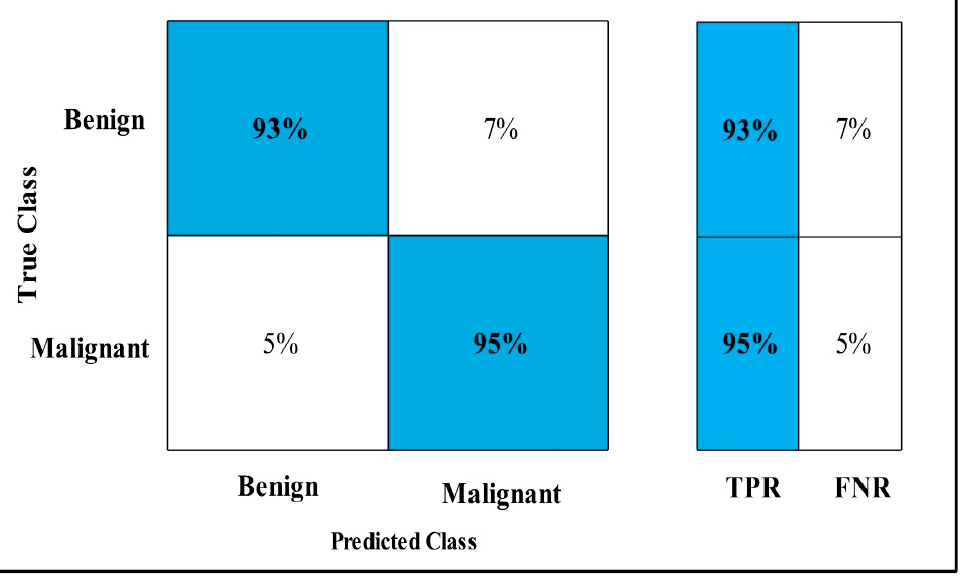
Table 4. Classification results using MEWOA on MobilenetV2 deep features for